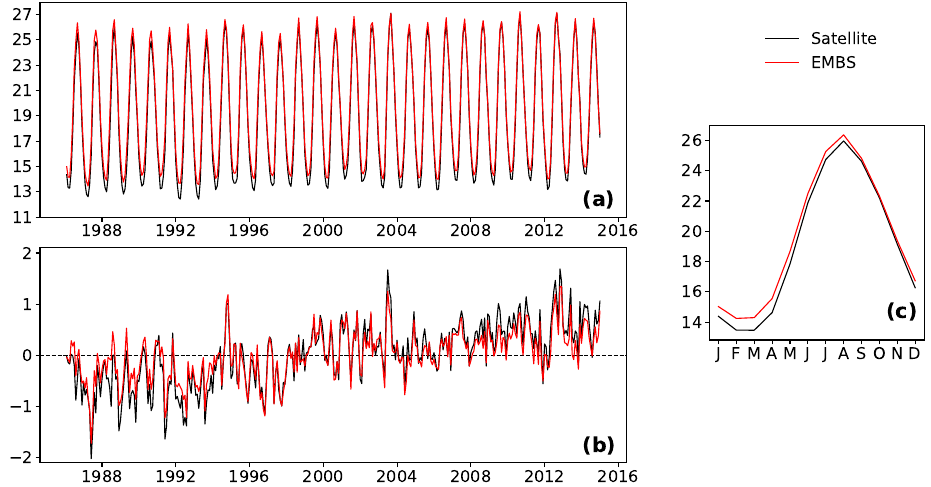
Figure 4. Basin-averaged monthly SST for the whole Eastern Mediterranean–Black Sea system. ( a ) SST timeseries, ( b ) deseasoned signal (monthly anomalies), and ( c ) seasonal SST cycle. All values in degrees Celsius, for satellite reanalysis (black) and EMBS simulation